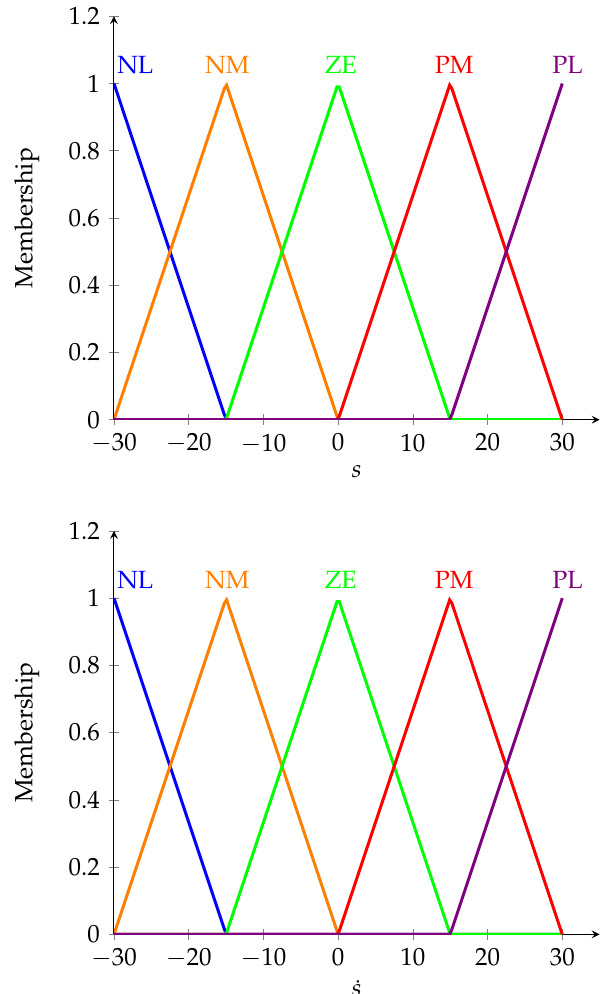
Figure 4. The input membership functions for s and ˙ s for the hip.